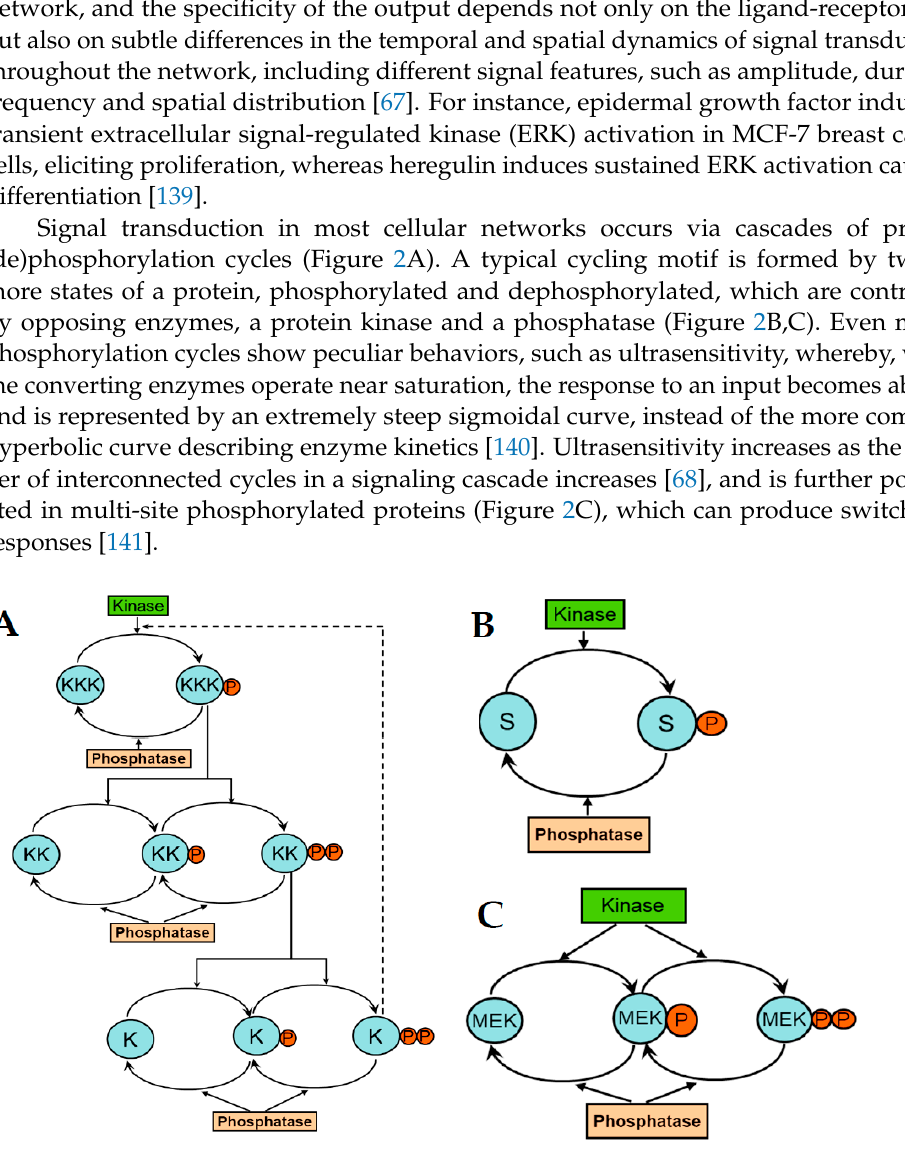
Figure 2. A cascade of protein (de)phosphorylation cycles. ( A ) The 3-tier cascade has a similar structure to MAPK cascades (KKK/KK/K). The phosphorylation of two sites is necessary for full activation of the kinases KK and K. Feedback loop is shown by a dashed line. ( B,C ) Typical cascade motifs are mono- and double (de)phosphorylation cycles.